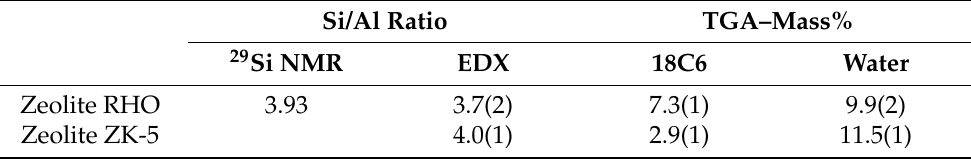
Table 2. The estimated Si/Al ratio of the filled zeolite samples, as estimated by 29 Si SS MAS NMR and EDX spectroscopy. Included is the estimated mass% content of 18C6 and water. Error in parentheses.